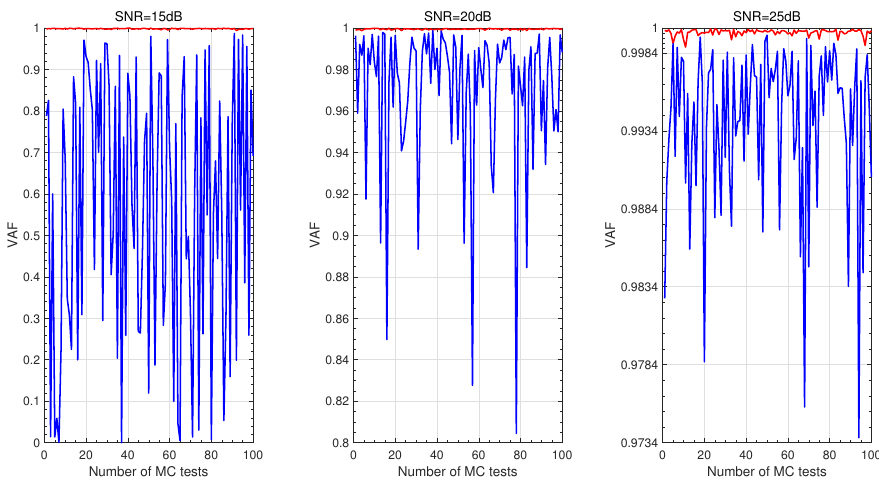
Figure 2. VAF of APM ( left , red line) and TSA ( right , blue line) under different